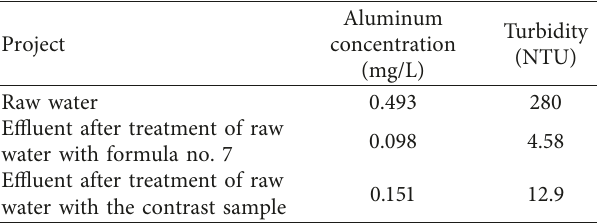
Table 14: Aluminum concentration in water after treatment by formula no. 7 of the chitosan composite flocculant and contrast sample. Project Raw water 280 Effluent after treatment of raw water with formula no. 7 Effluent after treatment of raw water with the contrast